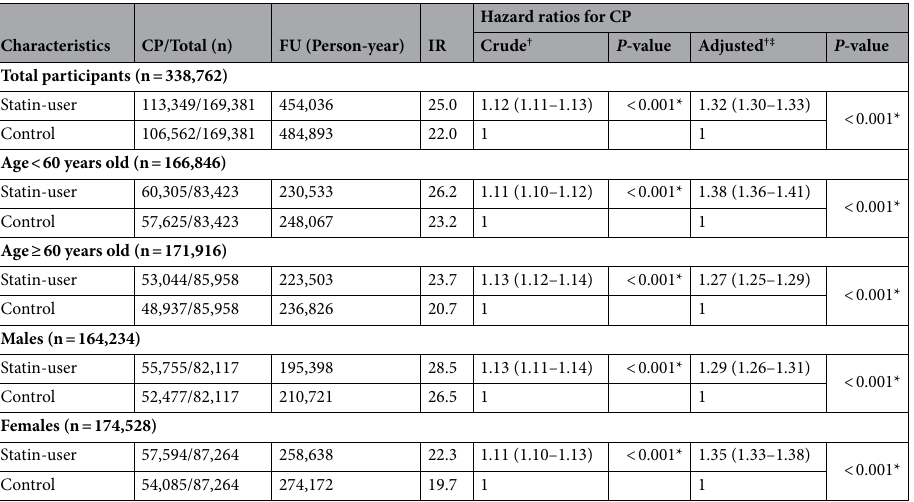
Table 3. Hazard ratio (95% confidence interval) for CP in the statin-user and control groups with subgroup analyses according to age and sex. CP chronic periodontitis, FU Follow-up duration, IR Incidence rate per 100 person-years. *Stratified Cox proportional hazard model, Significance at P < 0.05. † Models were stratified by age, gender, income, and region of residence. ‡ Adjusted for dyslipidemia history, total cholesterol, systolic blood pressure, diastolic blood pressure, fasting blood glucose, obesity, smoking, alcohol consumption, the number of previous CP, and CCI scores.